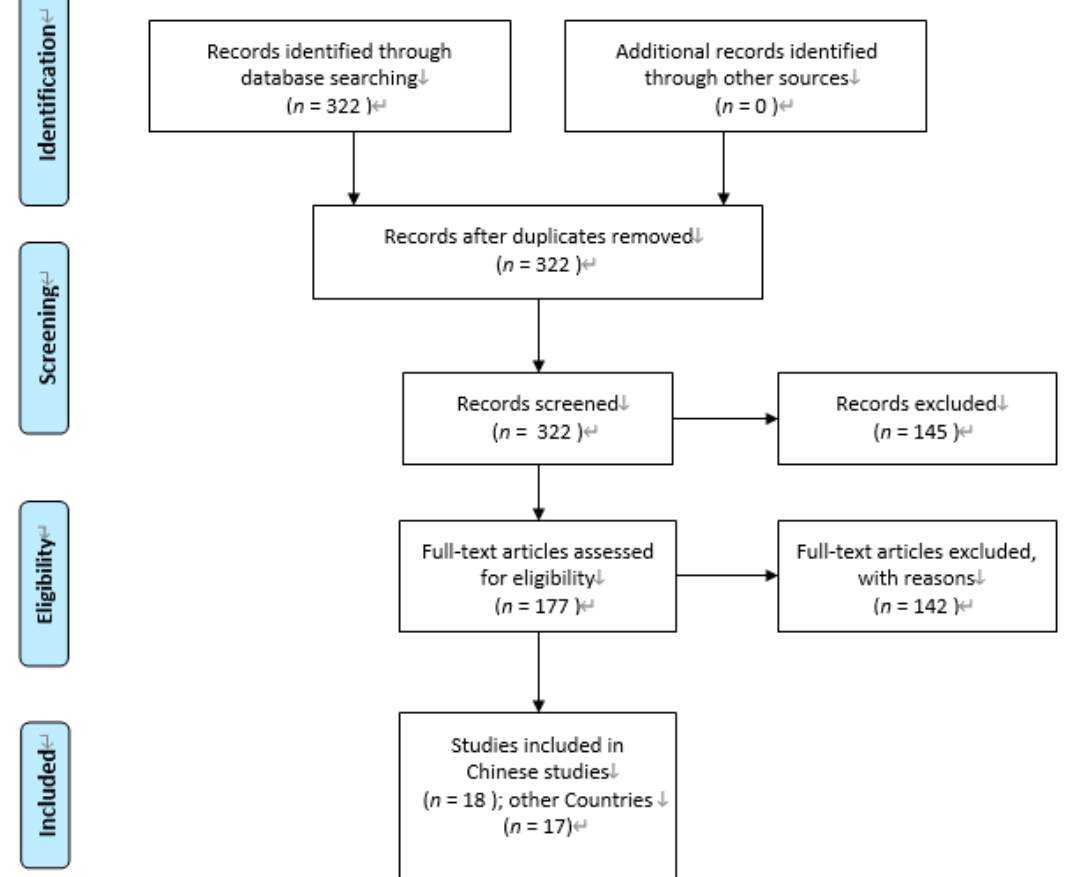
Figure 1. Flow diagram of study selection (PRISMA). Note: Moher D, Liberati A, Tetzlaff J, Altman DG, The PRISMA Group (2009) [21].